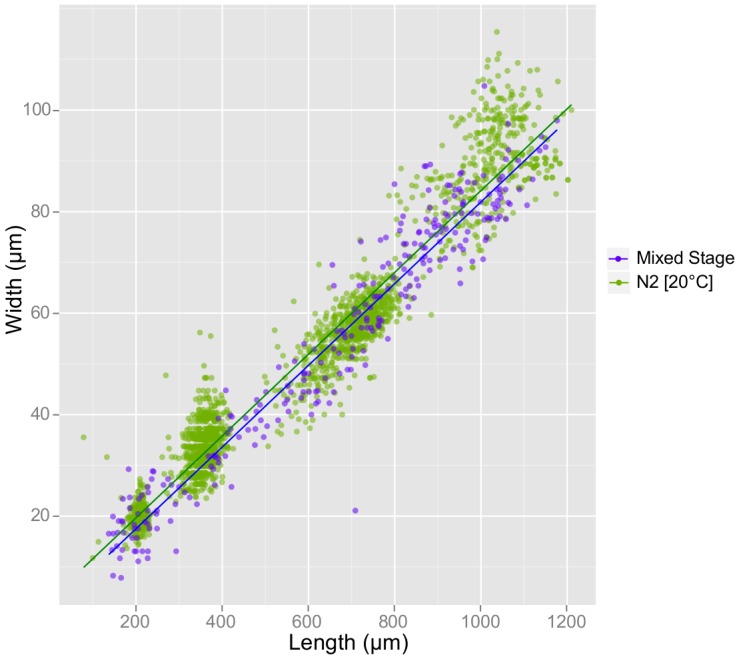
WormSizer can be used on mixed stage populations.Length and width of individual animals are plotted for a mixed staged population (purple) and a staged population over time (green). Shape (length versus width) is not affected by culture method, as revealed by a pair of linear regressions with similar slope (Table 4).